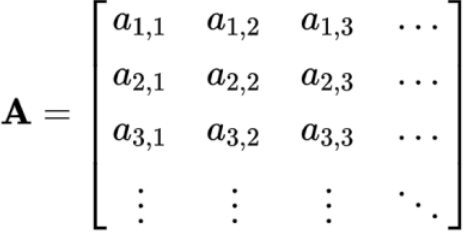
Figure 4. Use of K-means clustering set a group into a symmetric matrix.